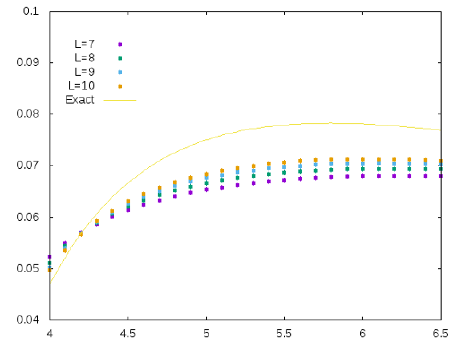
Figure 8 . The critical exponent plotted vs. k , using the values r = 2 : 5 and j = 0. It can be seen that the (cid:12)nite-size values for the critical exponents converge (slowly) to the exact